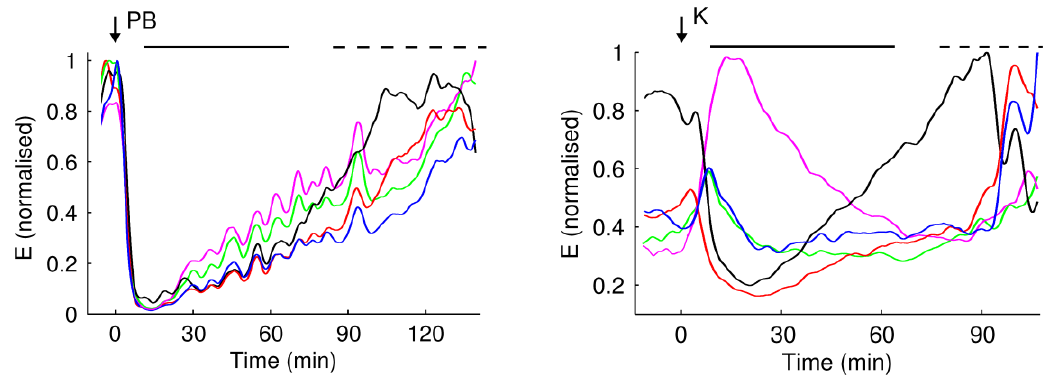
Figure 3. Relative amplitude changes in EEG frequency bands during pentobarbital (PB) and ketamine (K) anaesthesia in an animal model. Legend to colour coded EEG wave bands: black (  ), red (θ), blue (  ), green (  ) and violet (  ). The solid horizontal line denotes a deep general anaesthesia; the dotted horizontal line denotes a shallow general